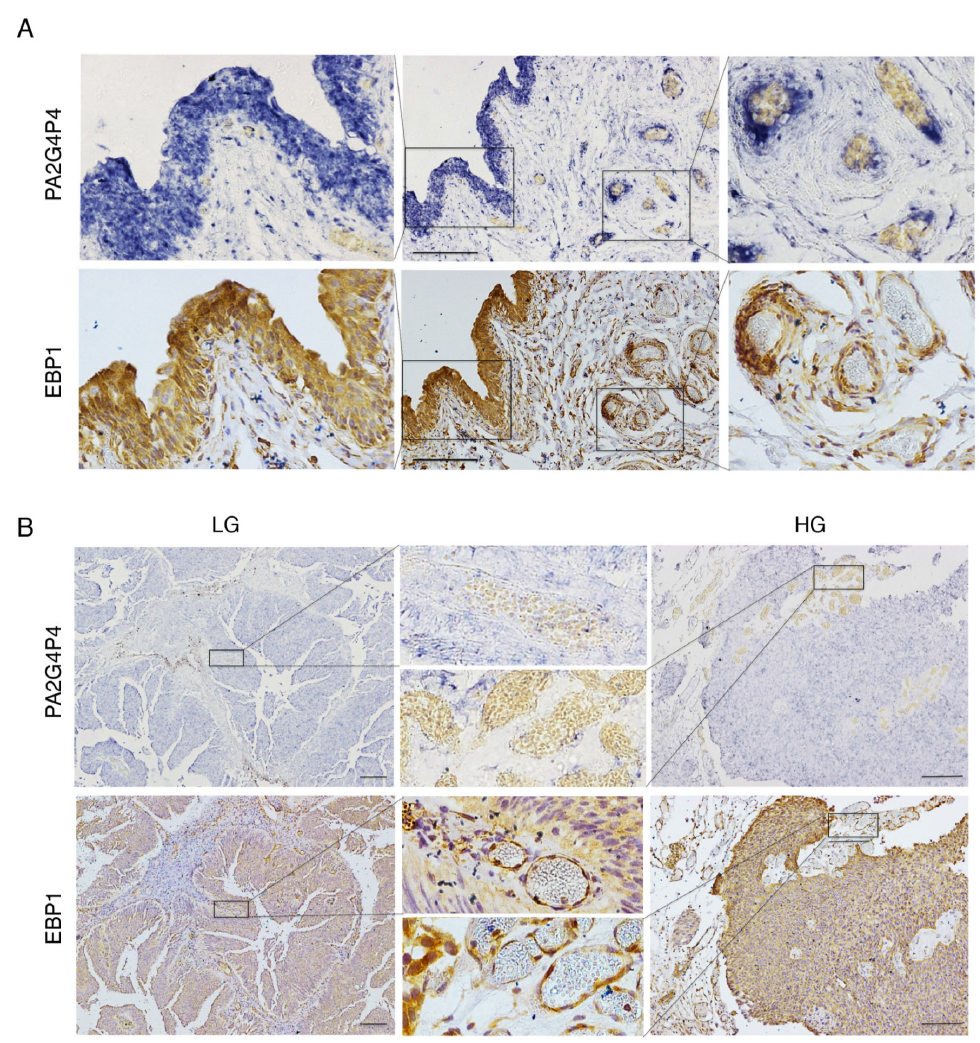
Figure 3. Histological analysis of the PA2G4P4 transcript and EBP1 protein. Analysis of PA2G4P4 transcript distribution and comparison with EBP1 protein localization in both urothelial carcinomas and adjacent non-tumoral bladder tissues. Panel ( A ) refers to non-tumoral bladder tissues, while panel ( B ) shows the results on urothelial carcinomas. In both cases, serial sections were analyzed by digoxigenin in situ hybridization for PA2G4P4 transcript detection (upper part of the panels) or EBP1 immunohistochemistry (lower part of the panels). Squares indicate the magnified areas. Bars represent 200 μ m. PA2G4P4, proliferation-associated 2G4 pseudogene 4; EBP1, ErbB3-binding protein 1; LG, low-grade; HG, high-grade.